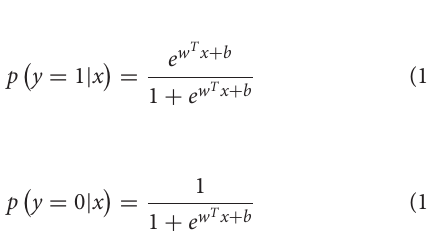
13 image features, and three clinical features (age, gender, and NIHSS